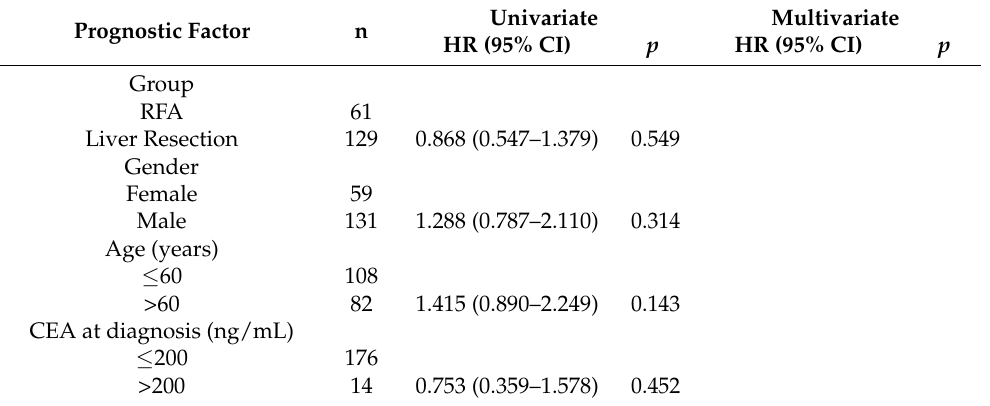
Figure 3. Kaplan–Meier survival curve for OS of RFA and liver resection groups. ( A ): Unmatched analyses; ( B ): PSM analyses. Table 5. Analysis of prognostic factors associated with OS.